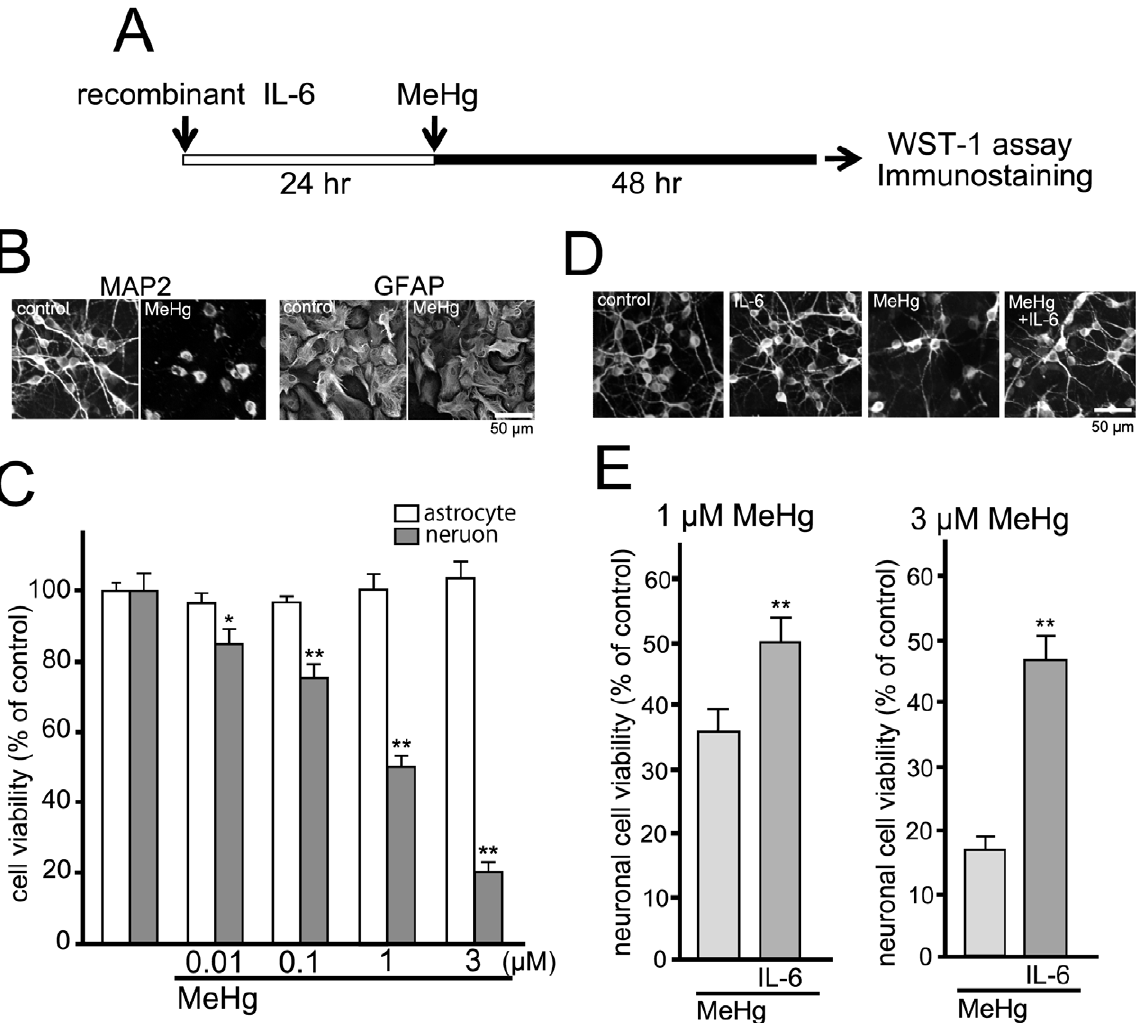
Figure 4. Neuro-protective effect of recombinant IL-6. ( A ) The experimental schedule. Recombinant IL-6 (100 pg/ml) was pretreated to the cell culture 24 hr before MeHg exposure (48 hr). Cells were then fixed for immunostaining or used for WST-1 assay. ( B ) MeHg-induced morphological changes in neurons. MAP2 signals in the processes were disrupted by MeHg (3 m M), whereas the GFAP signals exhibited no differences with or without MeHg. Scale bar: 50 m m. ( C ) MeHg-decreased the neuronal viability. Neuronal viability was significantly reduced by MeHg in a concentration- dependent fashion at a concentration range of from 0.01 to 3 m M (gray columns). MeHg did not affect the astrocytic viability (white columns). *P , 0.05, **P , 0.01 vs. control. ( D ) Recombinant IL-6 restored the MeHg-induced morphological changes in neurons. The collapsed MAP2 signals in neuronal processes were recovered in the presence of recombinant IL-6 (100 ng/ml). IL-6 did not change the neuronal morphology in controls. Scale bar: 50 m m. ( E ) IL-6 protects neurons against MeHg. Recombinant IL-6 (100 ng/ml) significantly restored the MeHg (1 or 3 m M)-reduced neuronal viability. **P , 0.01 vs. MeHg.